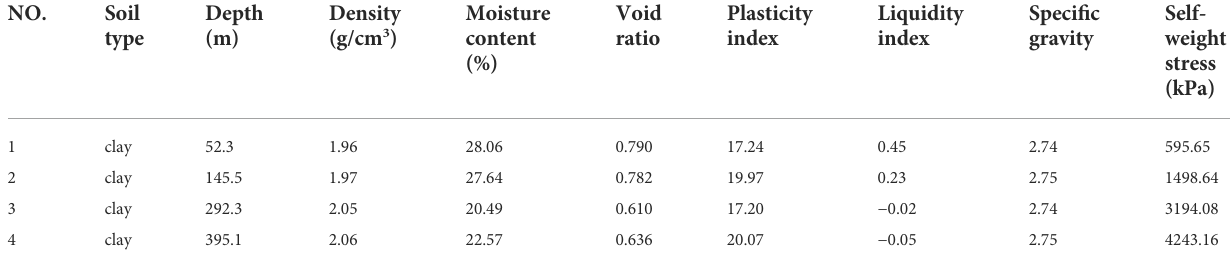
TABLE 1 Physico-mechanical properties of four soil samples taken from borehole dxzk02. NO.